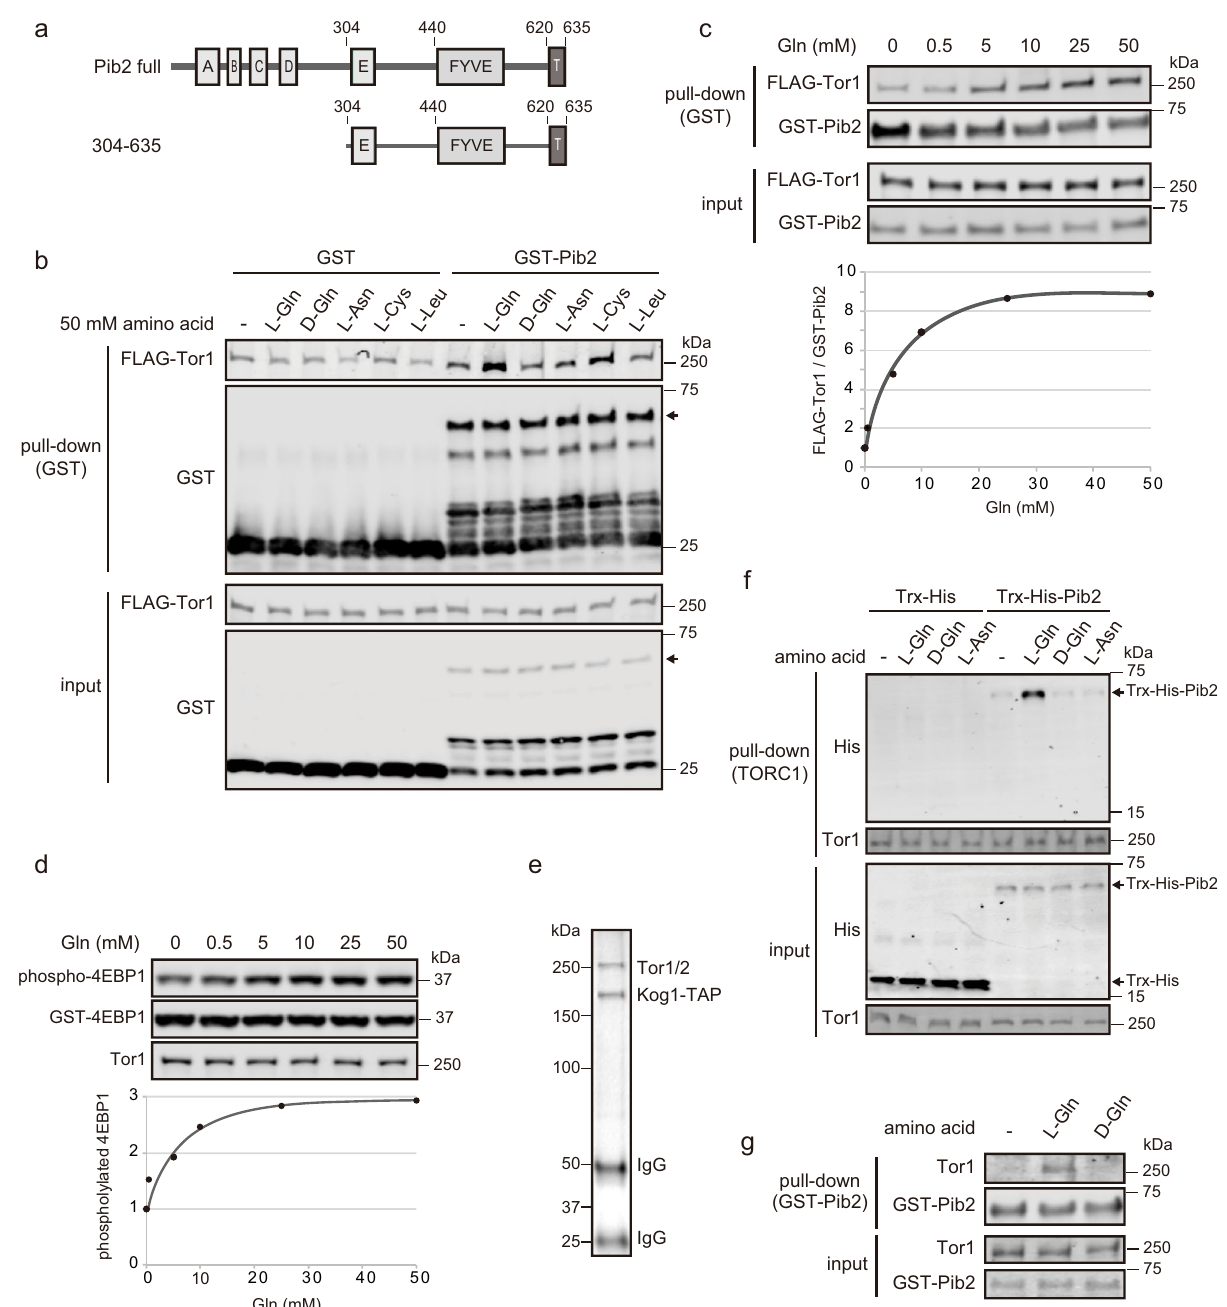
Fig. 1 In vitro reconstitution of the glutamine-responsive Pib2-TORC1 interaction. a Schematic diagram of full-length Pib2 with de fi ned motifs and the truncation mutant used in ( b , c , f , and g ). b L-glutamine and L-cysteine enhance the Pib2-TORC1 interaction in vitro. Lysates from FLAG-Tor1 expressing yeast cells (TS269) were subjected to pull-down assays with bacterially-expressed GST-Pib2(304-635) and the indicated amino acids ( fi nal concentration 50 mM). c The Pib2-TORC1 interaction depends on glutamine dose. Pull-down assays were performed as in ( b ), except that the indicated concentrations of L-glutamine were added to the cell lysates. The line graph shows GST-Pib2-bound FLAG-Tor1 normalized to sample without glutamine. d In vitro Pib2- dependent TORC1 activity depends on glutamine dose. In vitro TORC1 kinase assays monitored Pib2-dependent TORC1 activation using permeabilized yeast cells as the kinase source with the indicated concentrations of L-glutamine. The line graph shows the ratio of phosphorylated 4EBP1 to total 4EBP1 normalized to sample without glutamine. e Silver-stained SDS-PAGE gel for TORC1 puri fi ed from Kog1-TAP-expressing yeast cells (RL171-2a) using IgG- coupled magnetic beads. f Pib2 and TORC1 are suf fi cient to induce their glutamine-induced interaction. Bacterially-expressed and puri fi ed Trx-His- Pib2(304-635) and TORC1 puri fi ed from yeast on magnetic beads were incubated with the indicated amino acids (30 mM). Trx-His-Pib2(304-635) co- precipitation with TORC1 was detected by western blotting. g Induction of the Pib2-TORC1 interaction by glutamine is stereospeci fi c. TORC1 was puri fi ed as in ( e ) and eluted from the beads using tobacco etch virus protease before being incubated with bacterially-expressed GST-Pib2(304-635) and the indicated amino acids (30 mM). TORC1 co-precipitation with GST-Pib2 was detected by western